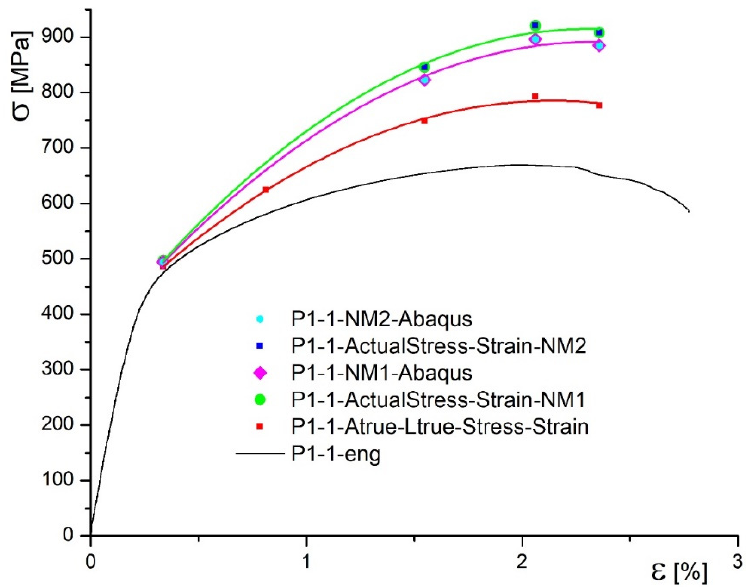
Figure 11. Actual stress–strain diagrams for the specimen P1-1.